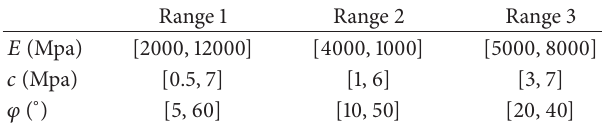
Table 3: The ranges of identified parameters.